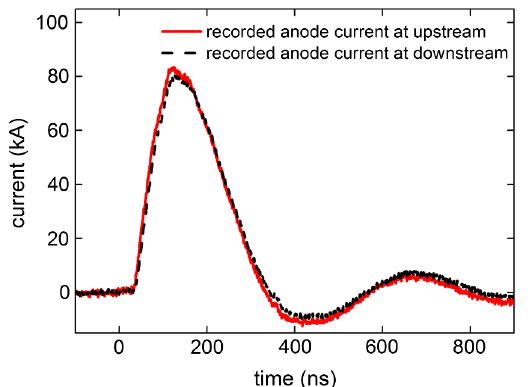
FIG. 9. Upstream and downstream anode currents in nonsup- port experiment. Currents are recorded at the same positions and postprocessed in the same manner as the support experiment. The maximum current is 83.4 kA at upstream and is 81.1 kA at downstream. Waveforms overlap well at both rising and trailing